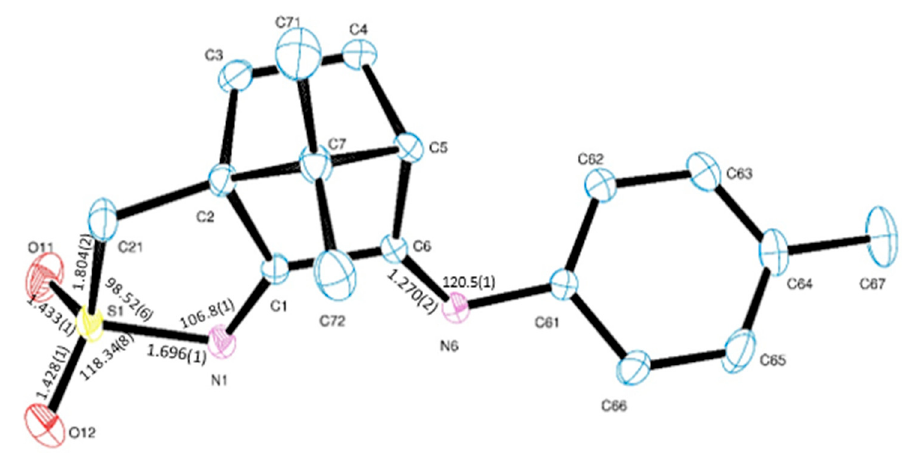
Figure 4. ORTEP drawing for SO 2 NC 10 H 13 NC 6 H 4 CH 3 − 4 ( 11 ) showing labelling scheme and selected bond lengths (angstrom) and angles (deg).